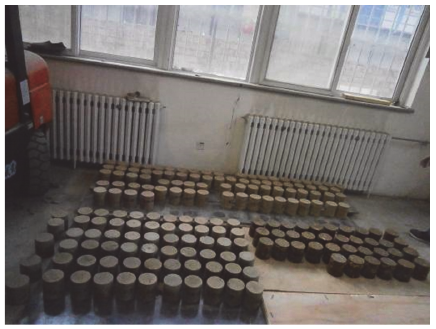
Figure 2: Air-cured